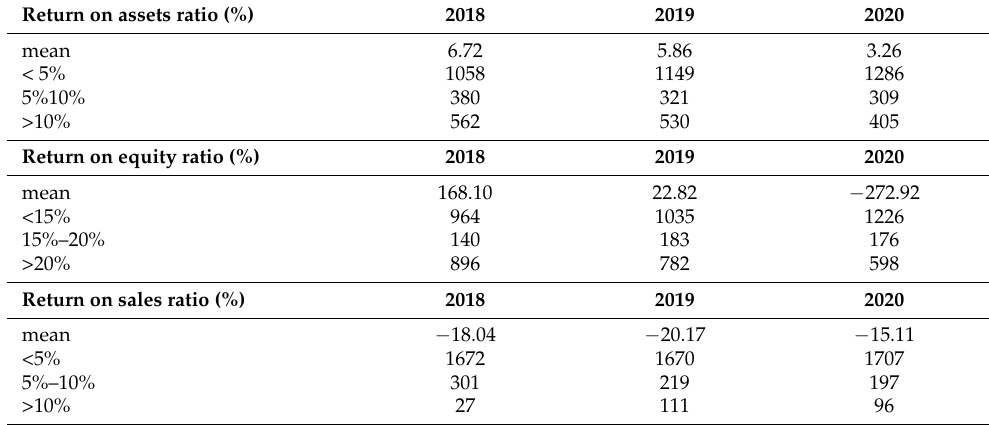
Table 6. Profitability ratios of the enterprises operating in the construction sector during 2018–2020. Return on assets ratio